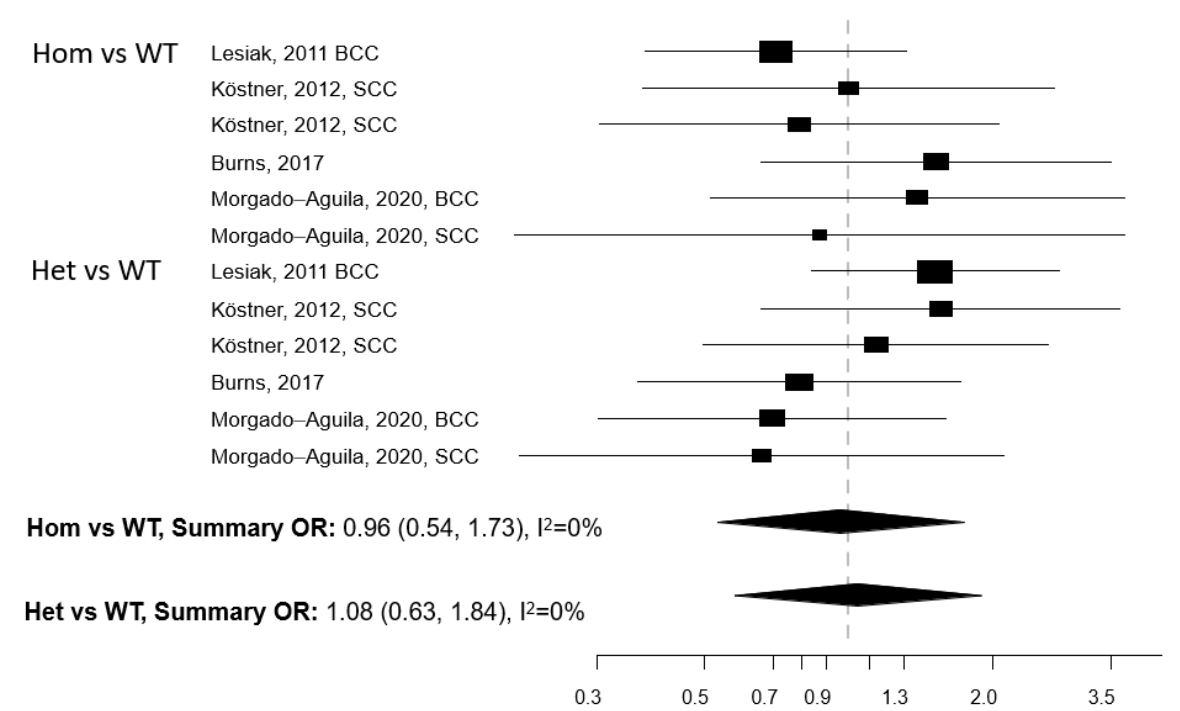
Figure 3. Forest plot for the association between the Apa1 polymorphism of the vitamin D receptor ( VDR ) gene and the risk of non-melanoma skin cancer. BCC: basal cell cancer. SCC: squamous cell cancer. RR: relative risk. Hom: homozygous. Het: heterozygous. WT: wild-type.